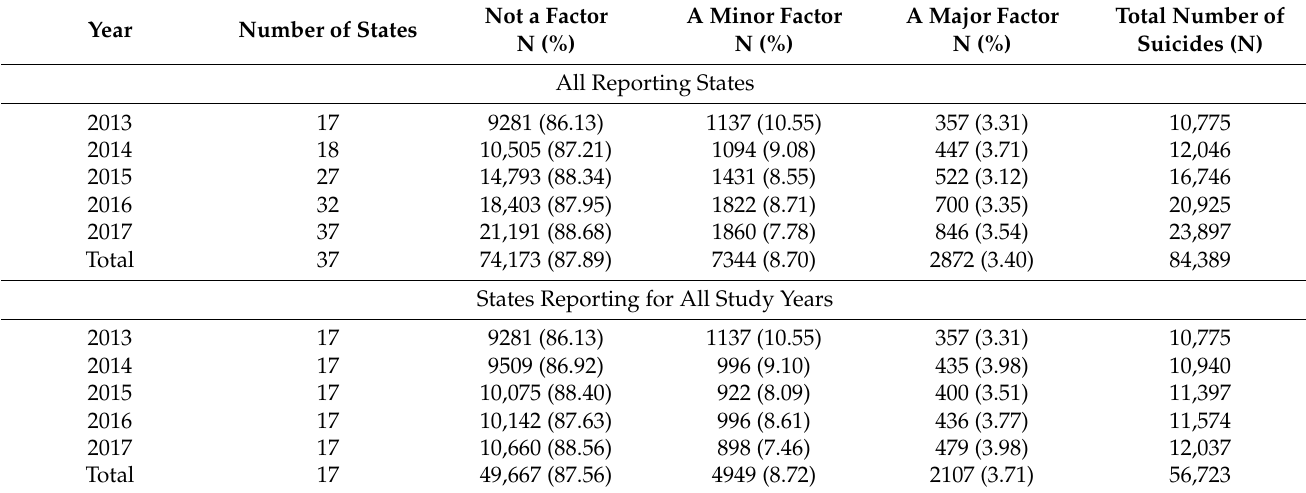
Table 1. Proportion of suicides for which work was a minor, major, or no contributing factor, National Violent Death Reporting System, by all reporting states and 17 states reporting each year from 2013 through